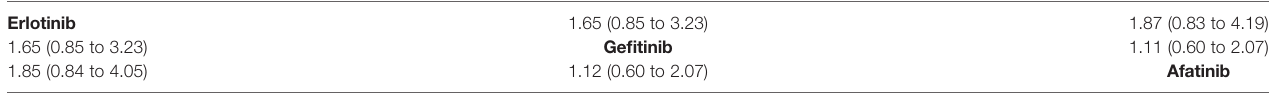
TABLE 3 | League table with network meta-analysis estimates of acquired T790M mutation rate in Asian patients. Ge fi tinib